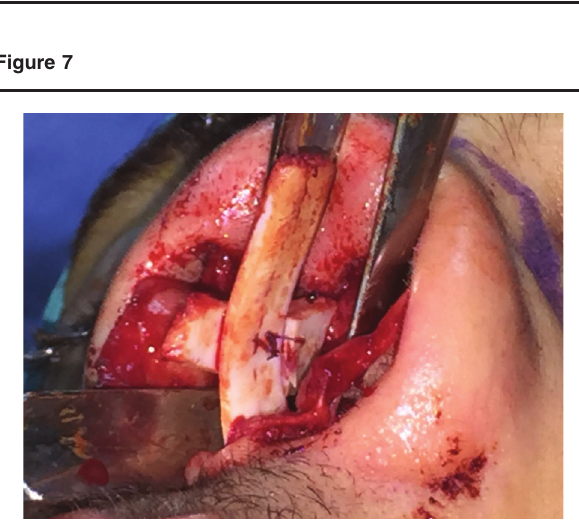
Septal L-strut reconstruction fixed after trimming excess cartilage.